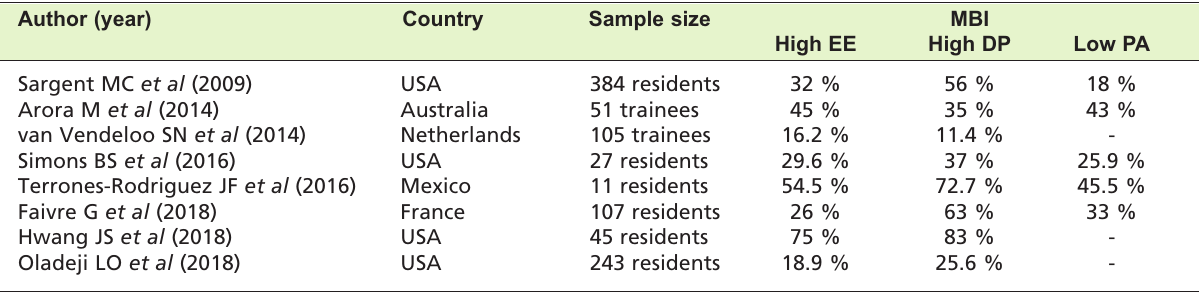
Studies using MBI for assessing burnout among orthopaedic residents Table I: Author